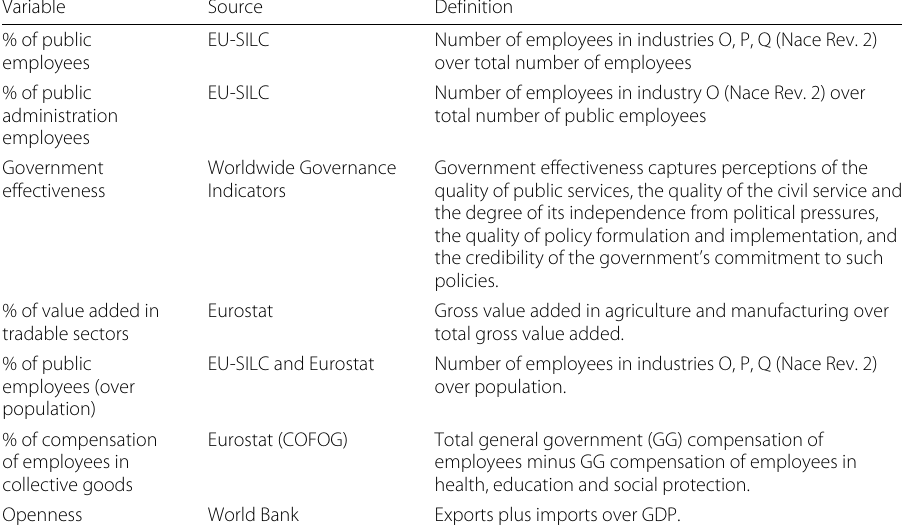
Table 7 Data: definitions and